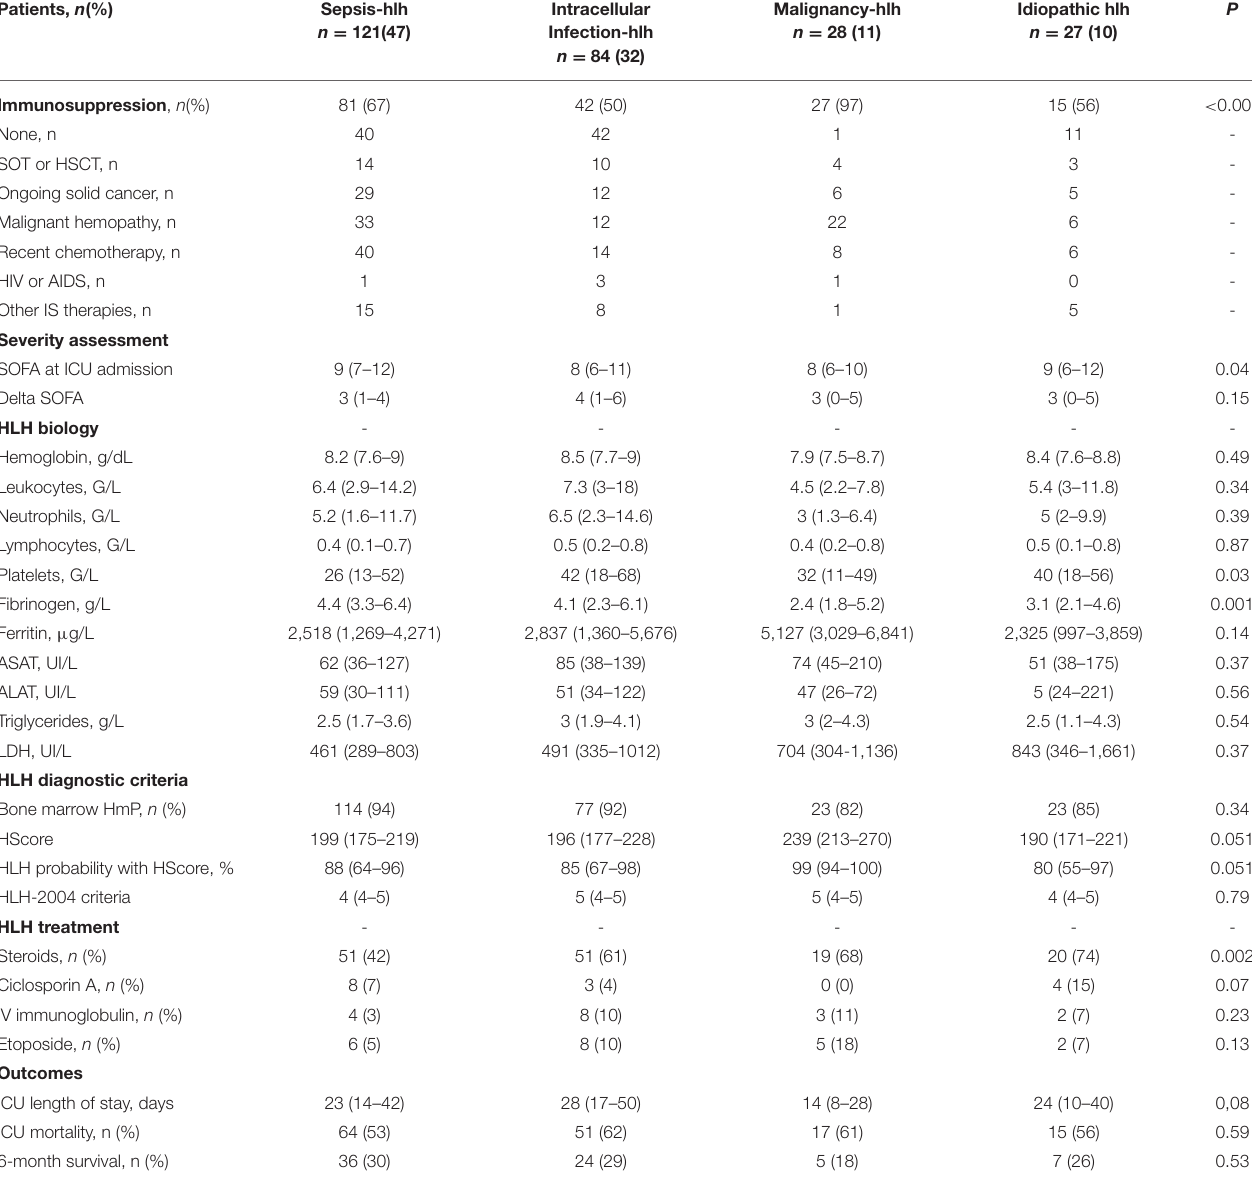
TABLE 2 | Patient characteristics according HLH etiological clusters. Patients, n